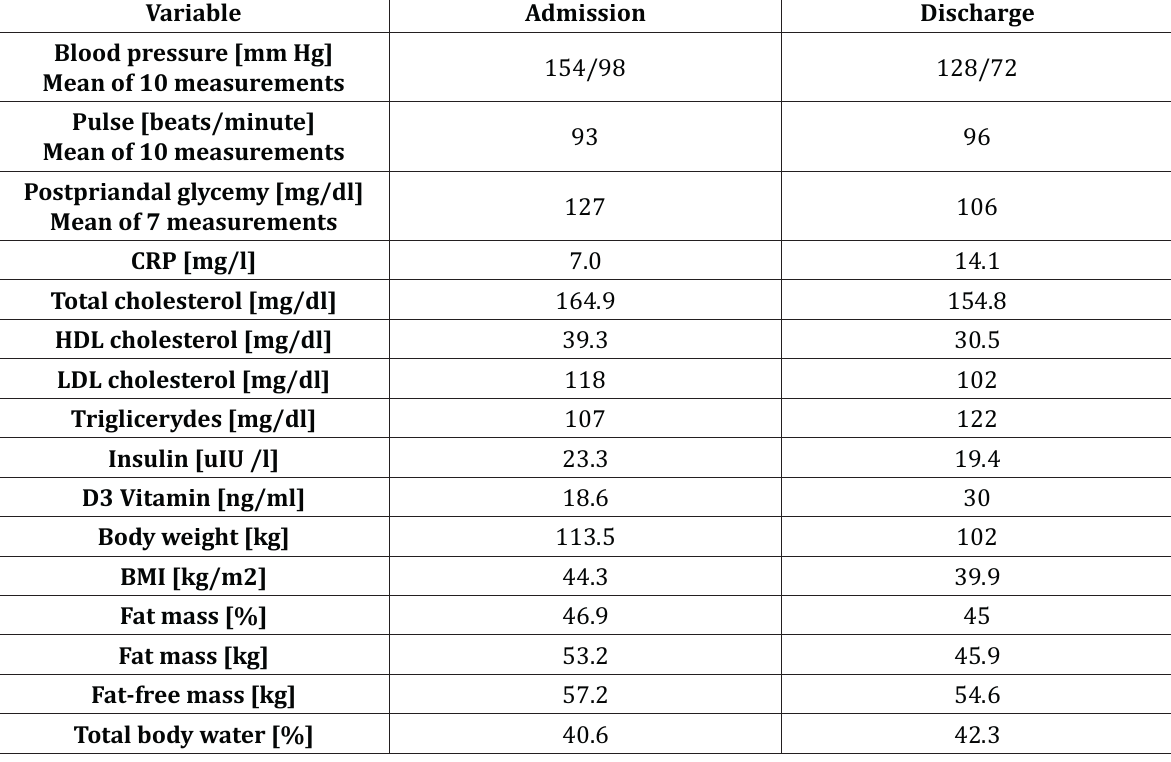
Table 2. The measurement of blood pressure and laboratory test